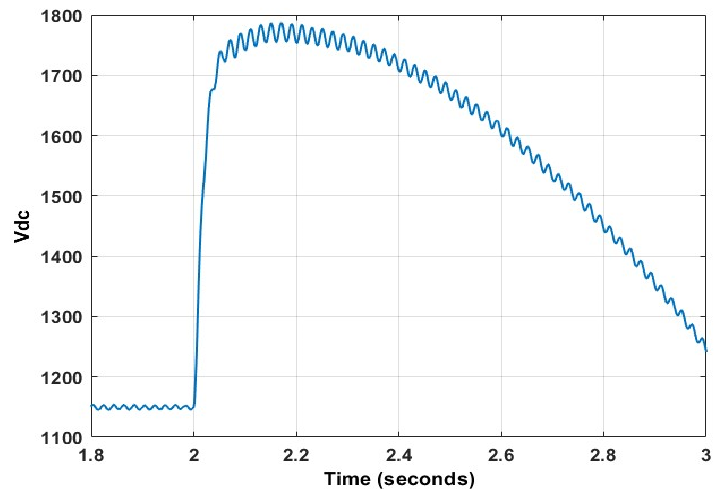
Figure 38. DC voltage transient using DCI at 80% dip.